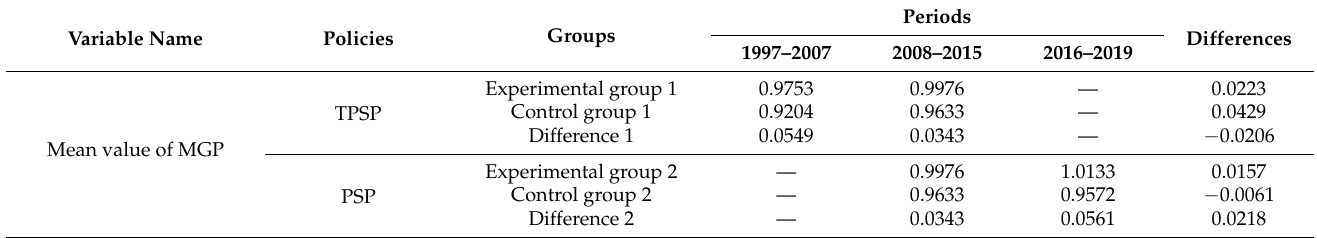
Table 3. Changes in the mean value of MGP before and after the implementation of TPSP and PSP.